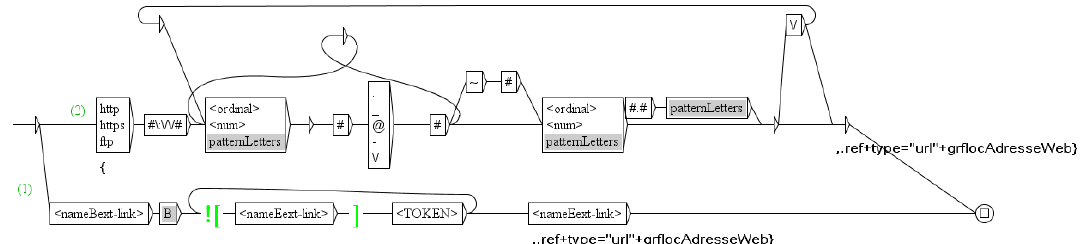
Figure 2. The graph to encapsulate